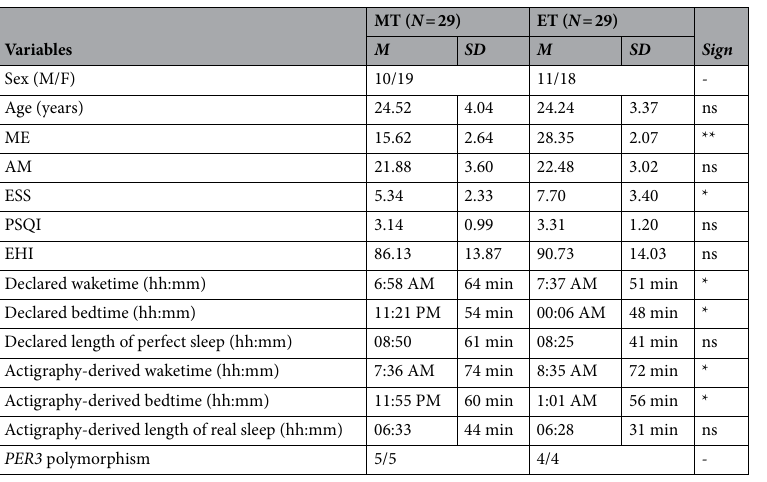
Table 1. Demographics, questionnaires and actigraphy results. Mann–Whitney U test, * p < 0.05, ** p < 0.001, ns not significant. MT morning types, ET evening types, ME morningness/eveningness scale from